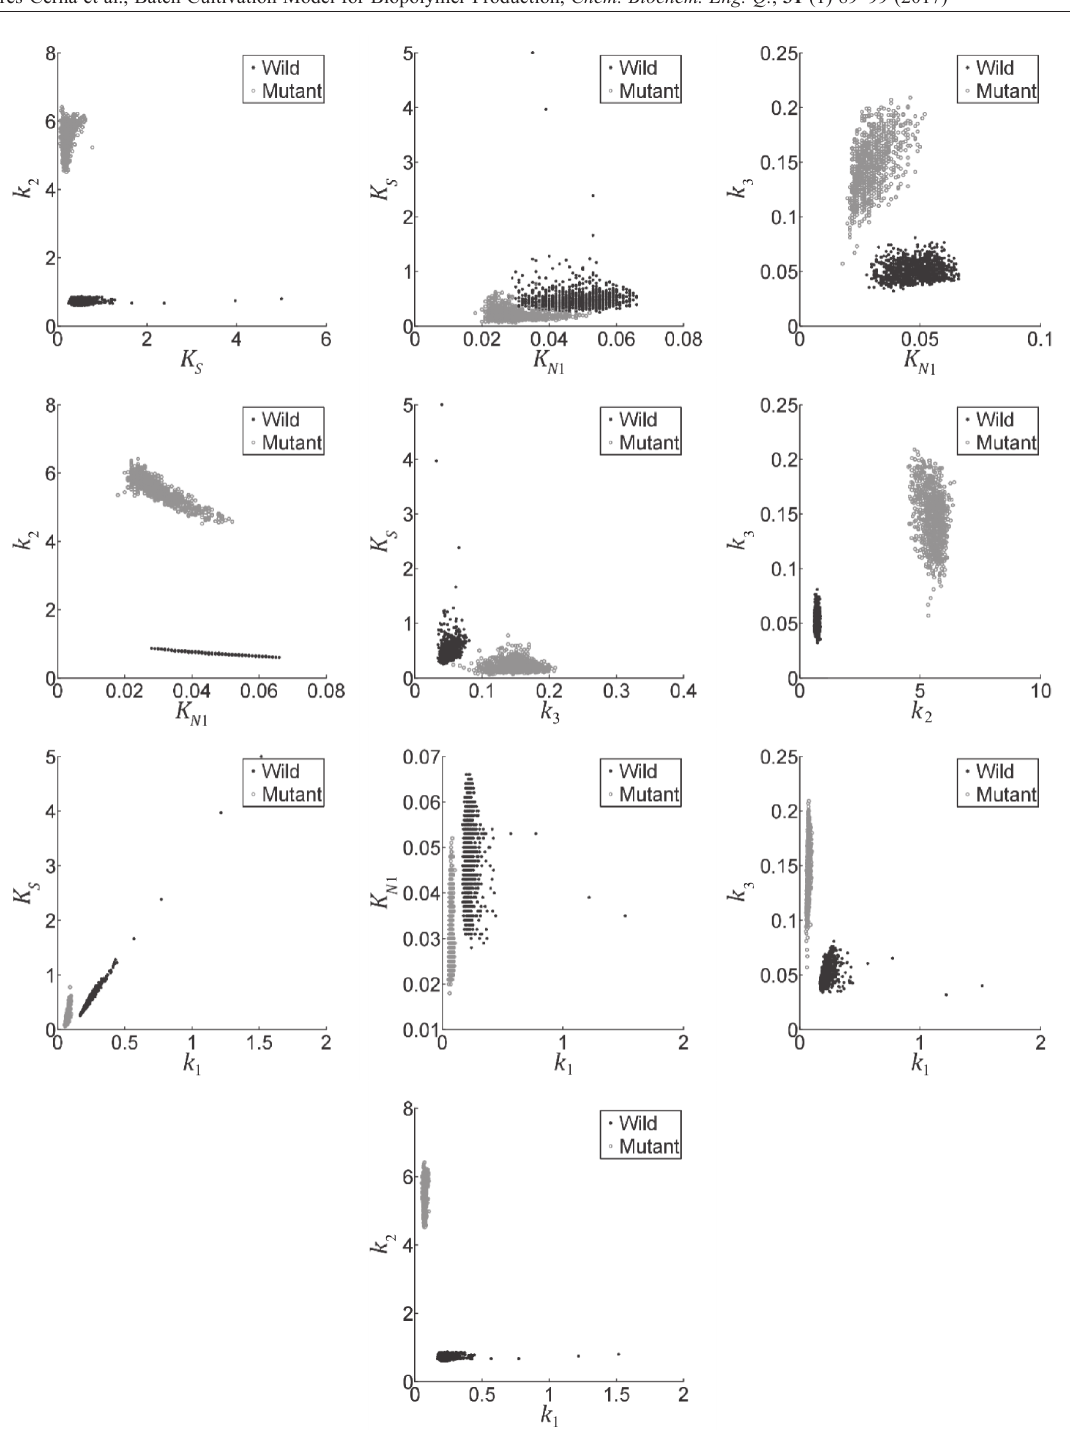
Fig. 6 – Parameter dependency. The scatter plots show the parametric dependence between parameters for both wild (black) and mutant (gray) strains. Data taken from bootstrap